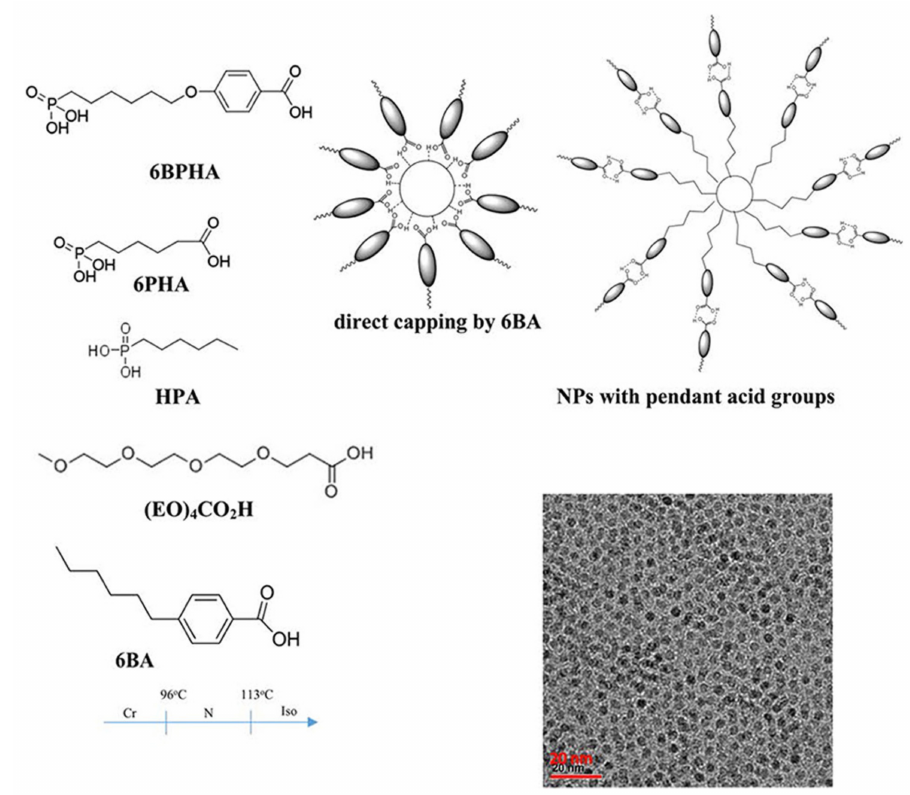
Figure 11. Schematic diagrams of LC molecules, ligands, functionalization types and proposed H-bonding interactions with the LC matrix along with a TEM image of the ZrO 2 nanoparticles. Reprinted with permission from reference [61]. Copyright (2016) American Chemical